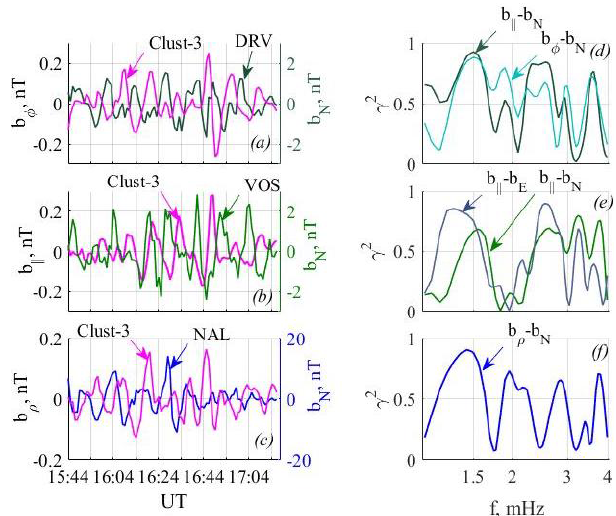
Figure 9. Pulsations in the magnetotail (Cluster 3) and in b N on Earth. Pulsations at Cluster 3 and at one of the ground stations are shown in panels (a) – (c) . The component with the maximal coher- ence at the f 1 frequency with the corresponding station is shown in panels (a) – (c) . In panels (a) – (c) , the left and right y axes correspond to Cluster 3 and the ground respectively. Spectral coherence for the same satellite–station pairs are given in panels (d) – (f) .